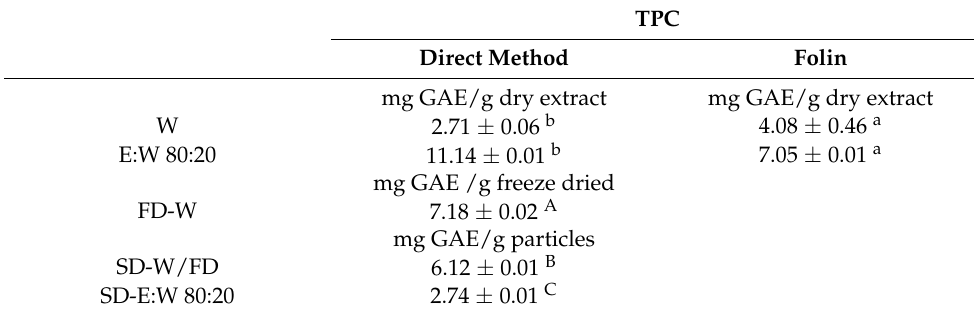
Table 4. TPC of extracts before and after processing by freeze and spray